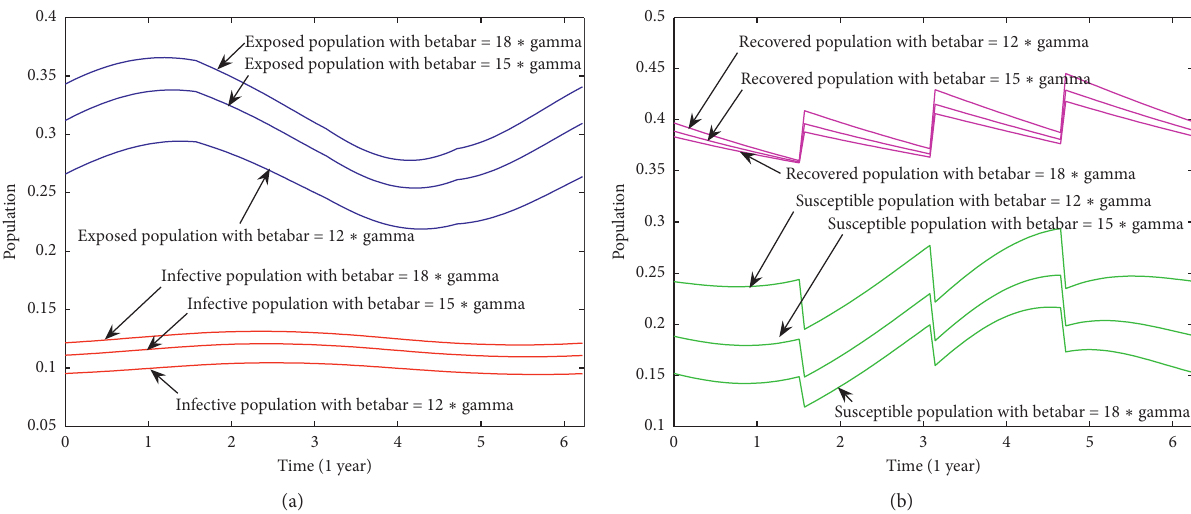
Figure 4: Exposed population, infective population, recovered population, and susceptible population with β � 12 c , β � 15 c , and β � 18 c